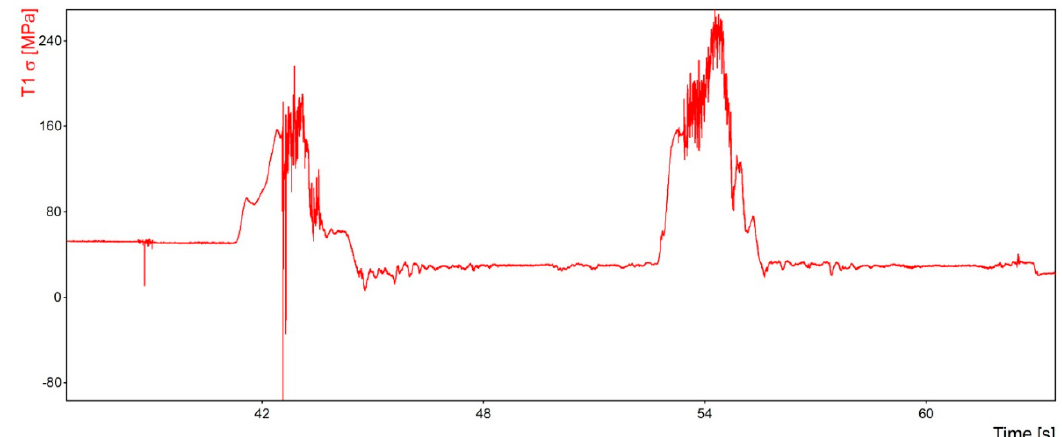
Figure 11. Stress patterns in the selected point T1 on the working arm [MPa].